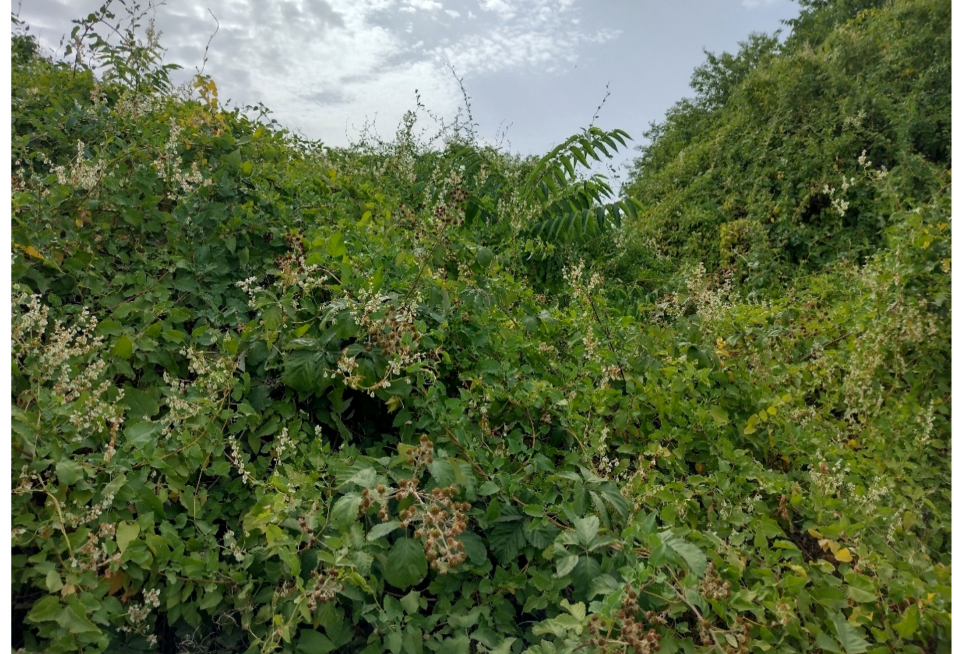
Figure 84. Fallopia baldschuanica on shrubby vegetation along a path running near Appia Nuova